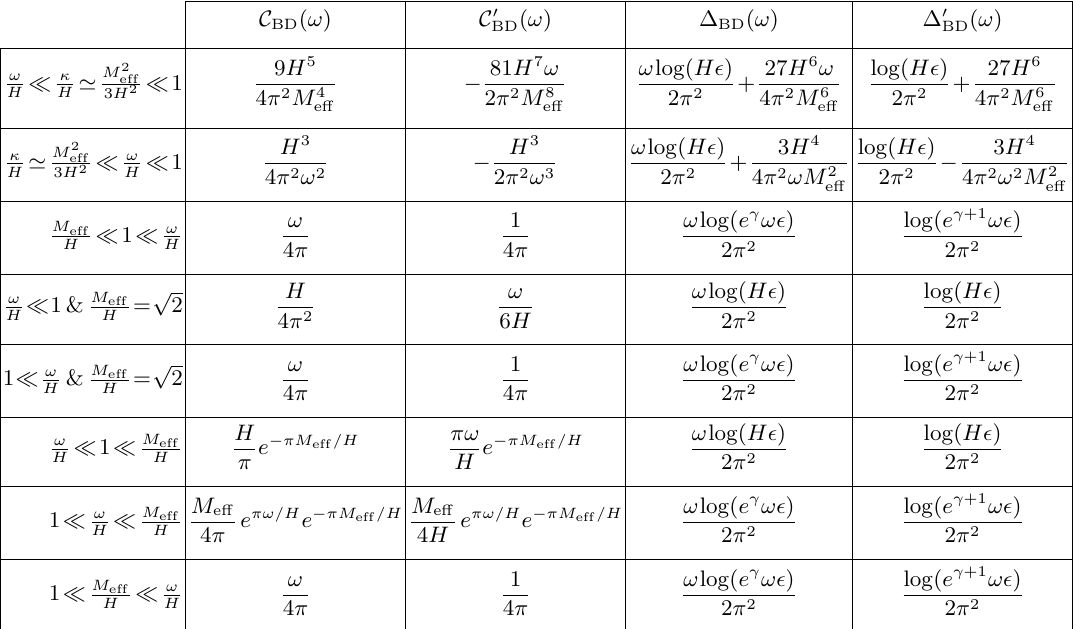
, (cid:1) BD and (cid:1) 0 in various regimes BD BD p 2 H . Here (cid:15) is the short-distance regulator